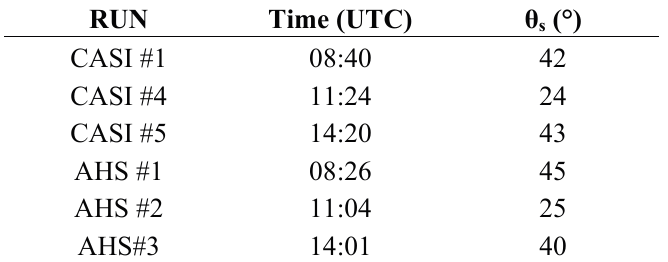
Table 2. Acquisition time (reported in UTC) and solar zenith angle ( θ s ) for the different runs acquired in the solar principal